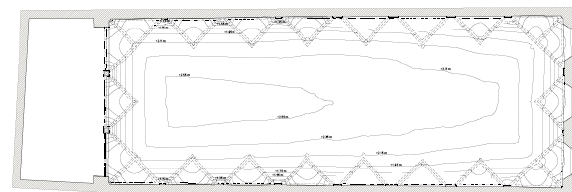
Figure 7. Level curves of the vault: north side on the right